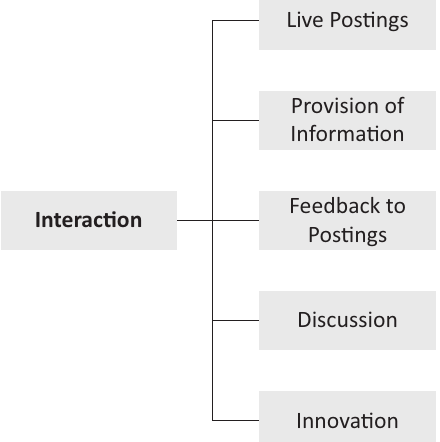
Figure 4. Advertisers’ expectations towards the interac- tion within a